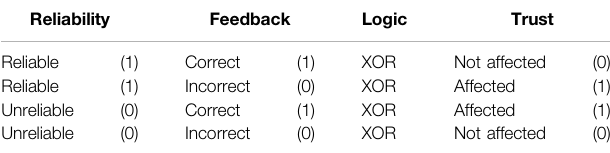
TABLE 5 | Boolean logic relationship between reliability and feedback and their effect on human trust compared to the case where no feedback is